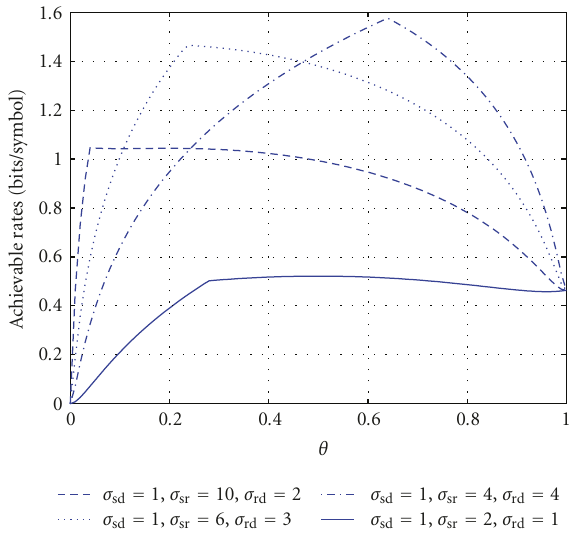
Figure 11: Nonoverlapped Parallel coding DF rate versus θ . P = 100, and m = 50.